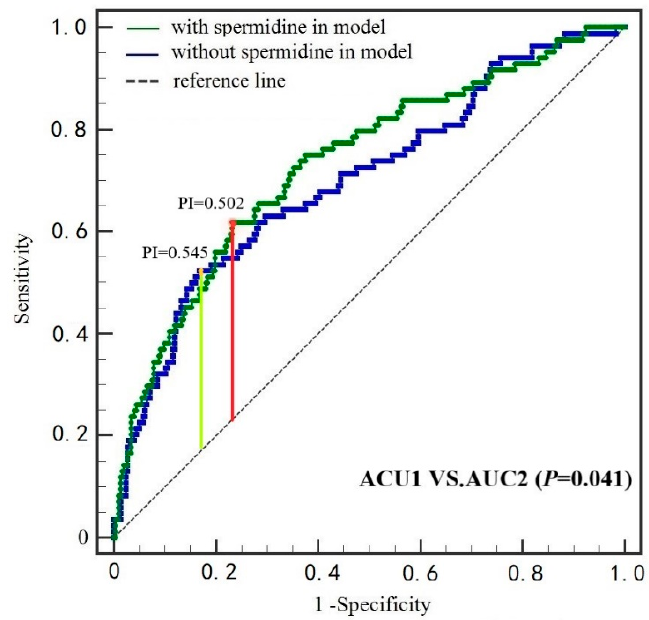
Figure 2. Receiving operating characteristics curves for MACE from Cox proportional hazards models with and without spermidine in patients with AMI ( n = 377). In the model with spermidine, the optimal cut-off value for PI was 0.502 at Youden’s index of 0.387, shown in red. In the model without spermidine, the optimal cut-off value for PI was 0.545 at Youden’s index of 0.357, shown in yellow. Comparison between the AUCs is noted in the bottom panel. MACE: major adverse cardiac events, AMI: acute myocardial infarction, PI: prognosis index, AUC: areas under the curves.